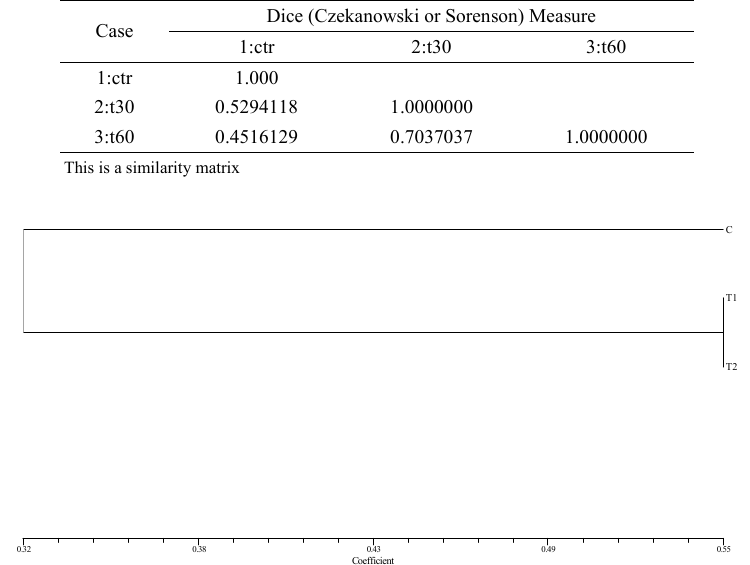
Table 8: Similarity matrix for the control samples and samples treated with CuO NPs